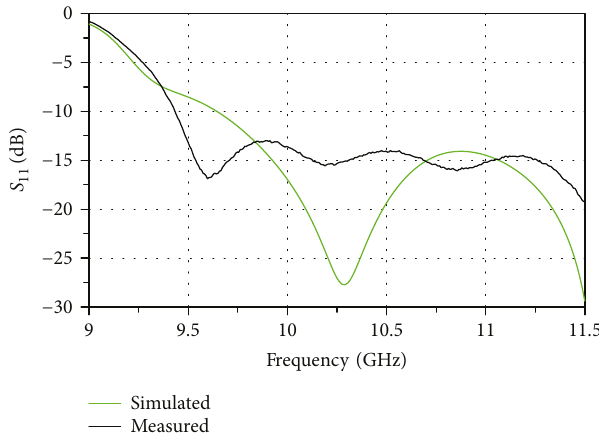
Figure 9: Measured S